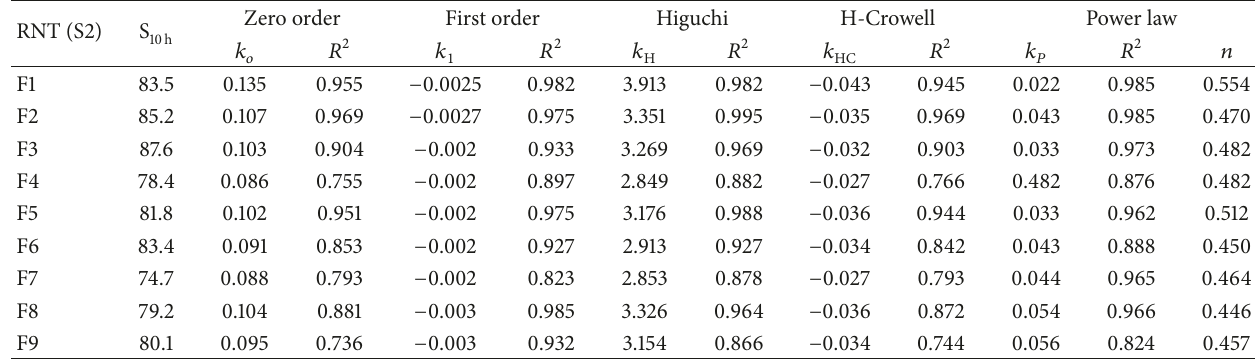
Table 8: DR study for 2nd batch matrix